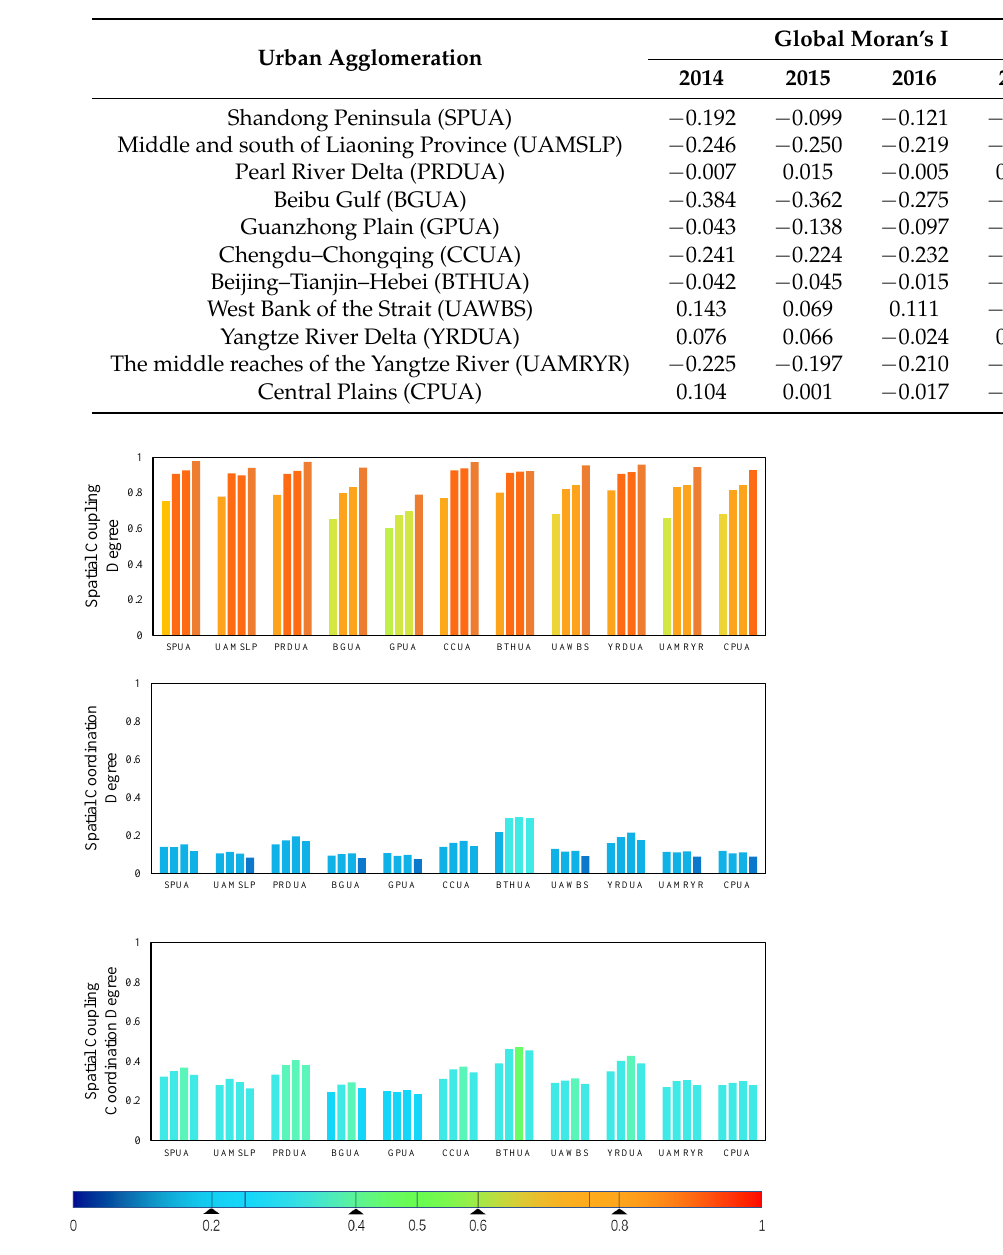
Figure 8. Spatial coupling coordination evaluation of 11 urban agglomerations (2014 – 2017).